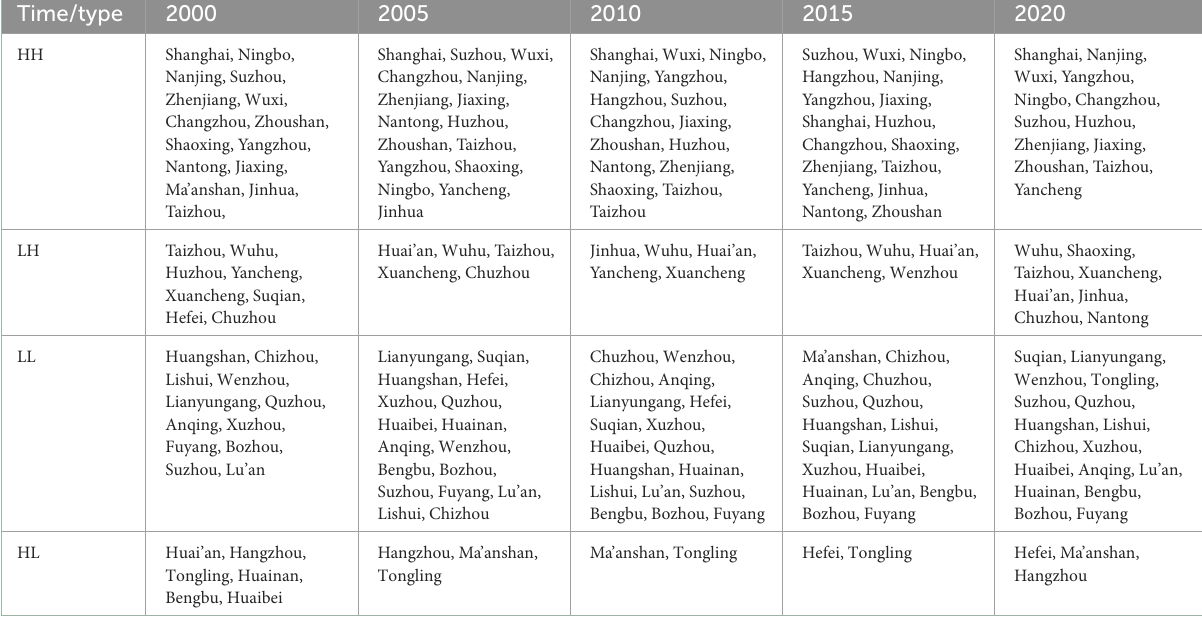
TABLE 2 Urban distribution based on Moran’s I scatter.